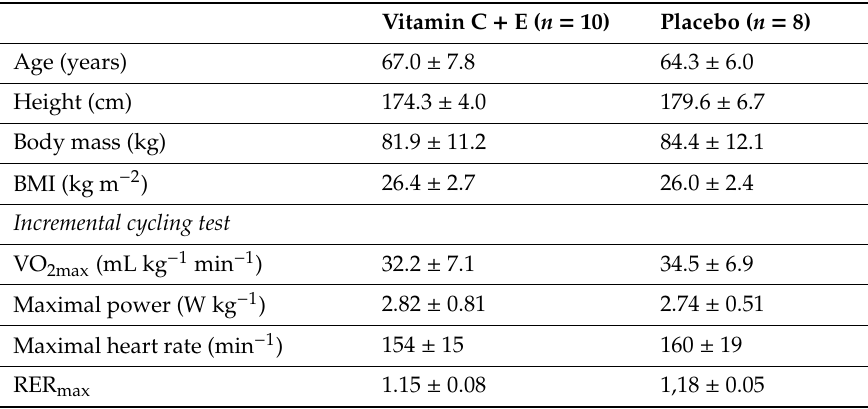
Table 1. Characteristics of participants at the start of the